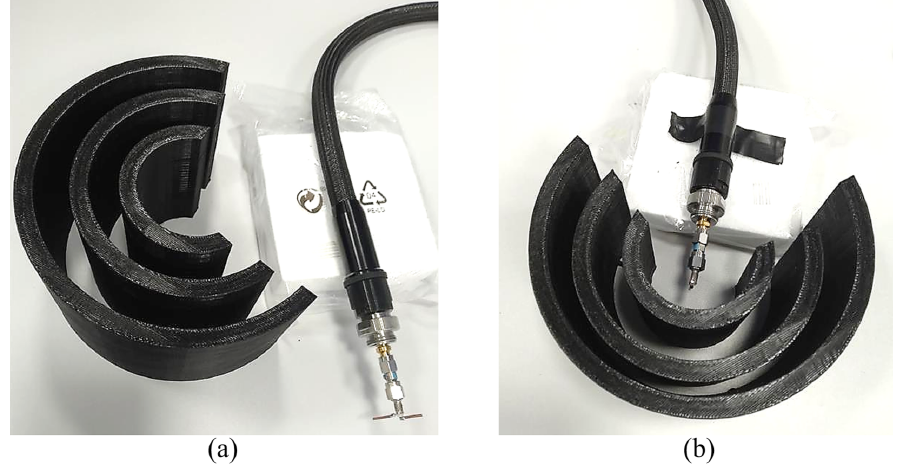
Figure 6. ( a ) The dipole antenna and the Bragg quasi-cylindrical structure and ( b ) the Bragg reflector around the dipole